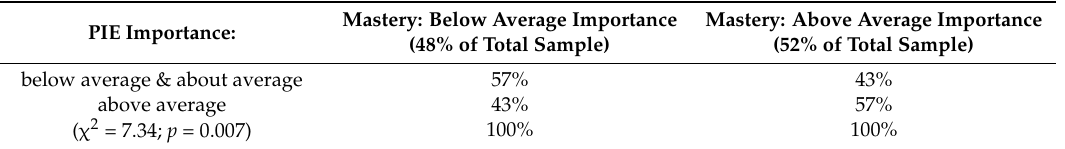
Table 5. Importance that Mastery & Participation, Improvement and Effort (PIE scale) should have in course